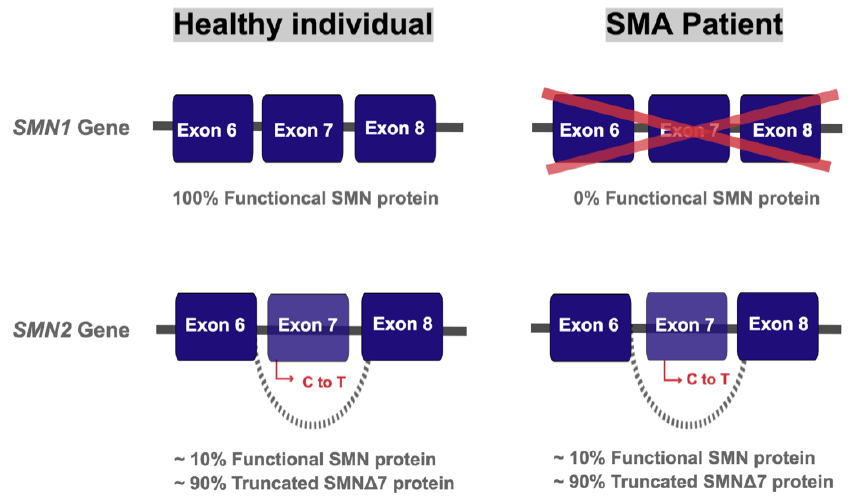
Figure 1. Genetics of spinal muscular atrophy (SMA). The SMN1 gene produces 100% full-length functional protein. The homologous SMN2 gene produces about 10% of full-length functional SMN protein and 90% of a truncated and rapidly degraded SMN ∆ 7 protein, due to a C to T substitution in exon 7. Healthy individuals retain copies of both SMN1 and SMN2 while SMA patients have a loss of SMN1 due to mutations and/or deletions.